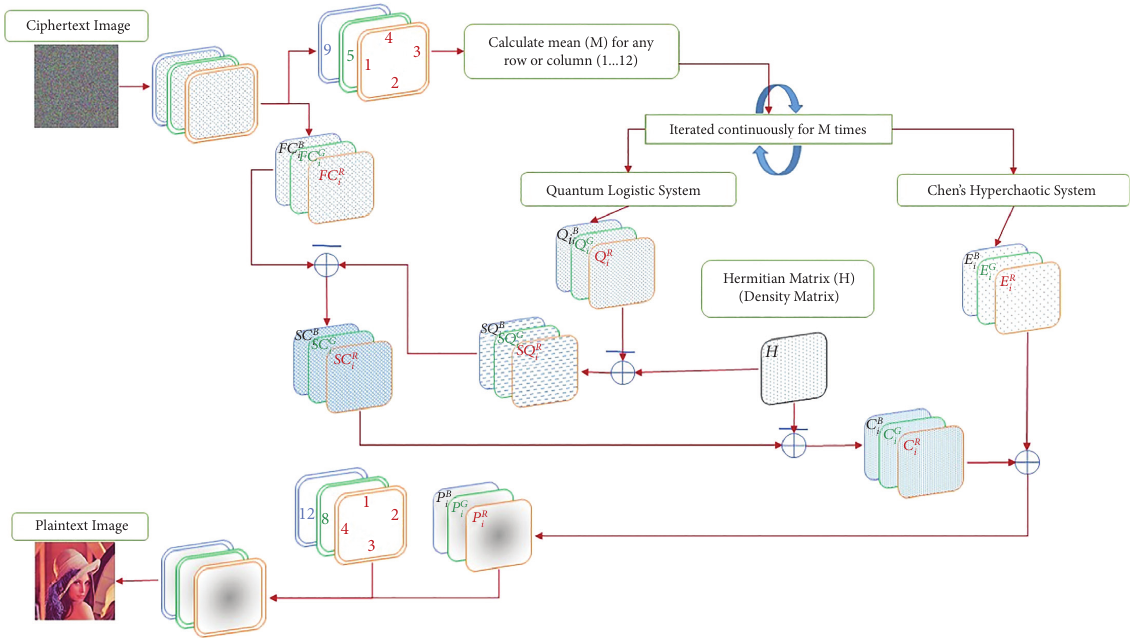
Figure 6: Block diagram of the proposed image decryption